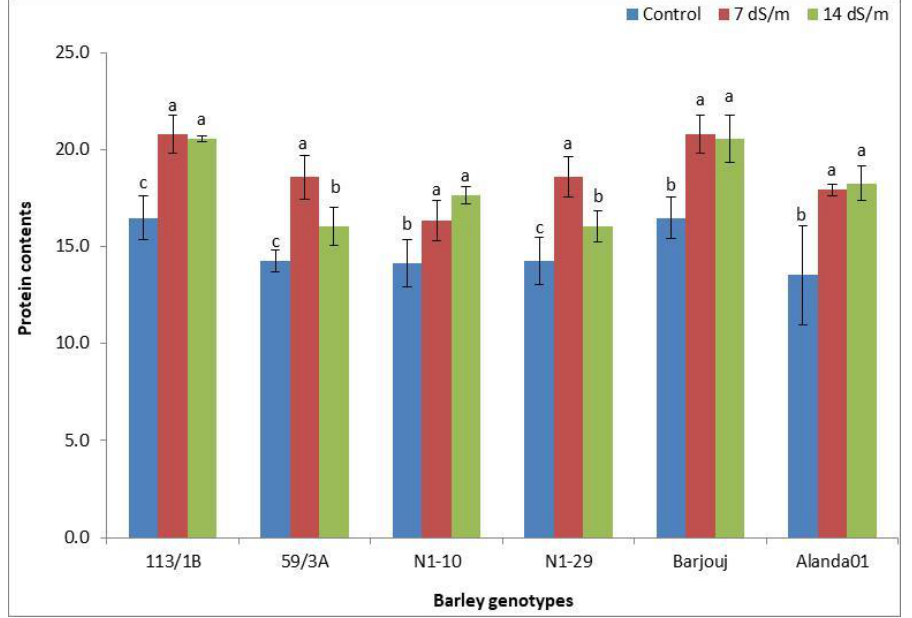
Figure 3. Changes in grain protein contents (mg g −1 ) in 6 barley genotypes following exposure to three different salinity levels (0, 7, 14 dS m −1 ). Each bar represents the mean (±S.E.) of three replicates. Bars with different lower case letters indicate significant difference with respect to control at p ≤ 0.05 according to Tukey’ s HSD test.